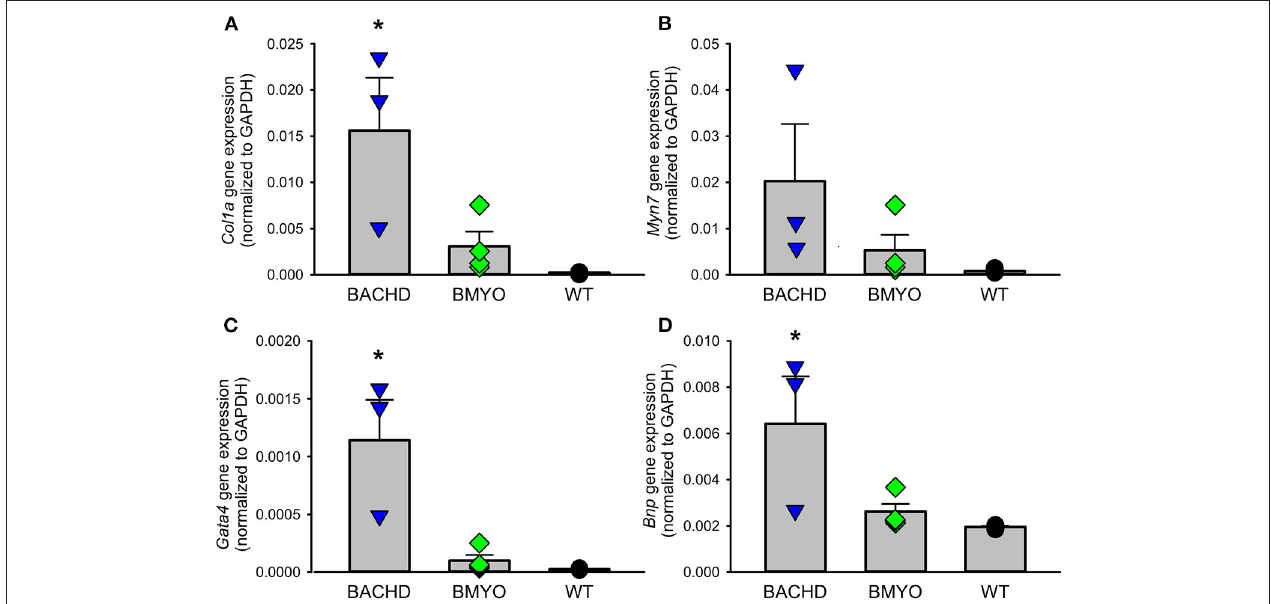
FIGURE 4 | Gene expression levels of molecular markers for cardiovascular injury and repair were significantly lowered by the specific removal of mHtt from the heart. (A) The expression levels of collagen 1a ( Col1a ) were significantly lower in the BMYO animals compared to the BACHD, while (B) the expression of ventricular/slow myosin heavy chain isoform ( Myh7 ) did not significantly change. (C) GATA binding protein 4 ( GATA4 ) and (D) brain natriuretic peptide ( BNP ) were both significantly diminished in the BMYO heart at 6 months of age as compared to BACHD (see also Table 2 for values derived from the statistical analyses). Together these data suggest that changes in molecular markers of CV injury were reversed by selective removal of the mHTT in the BMYO line. The vertical bar plots show group means and SEM. The symbols show the values from individual animals (n = 3–4 per genotype). Asterisks represent significant differences ( P < 0.05) compared to WT controls. One way ANOVA followed by Tukey’s multiple comparison test was used to evaluate the possible significance of the findings. If normality or equal variance tests failed, then Kruskal-Wallis one-way ANOVA on ranks followed by Dunn’s multiple comparison test was used instead (see also Table 2 ).